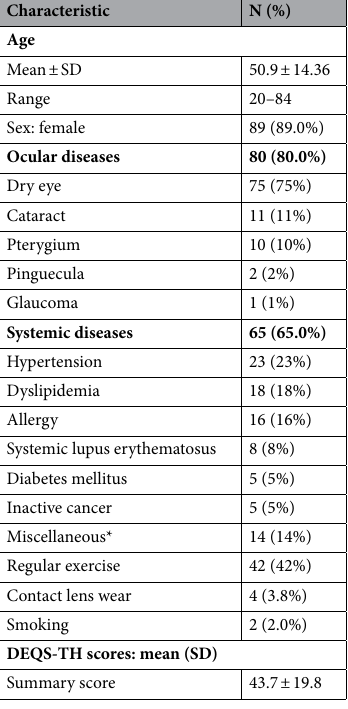
Table 1. Demography and characteristics of participants with DED (N = 100). DED dry eye disease, SD standard deviation, DEQS Dry Eye-related Quality-of-Life Score, *Hypothyroidism (4), gout (2), osteoporosis